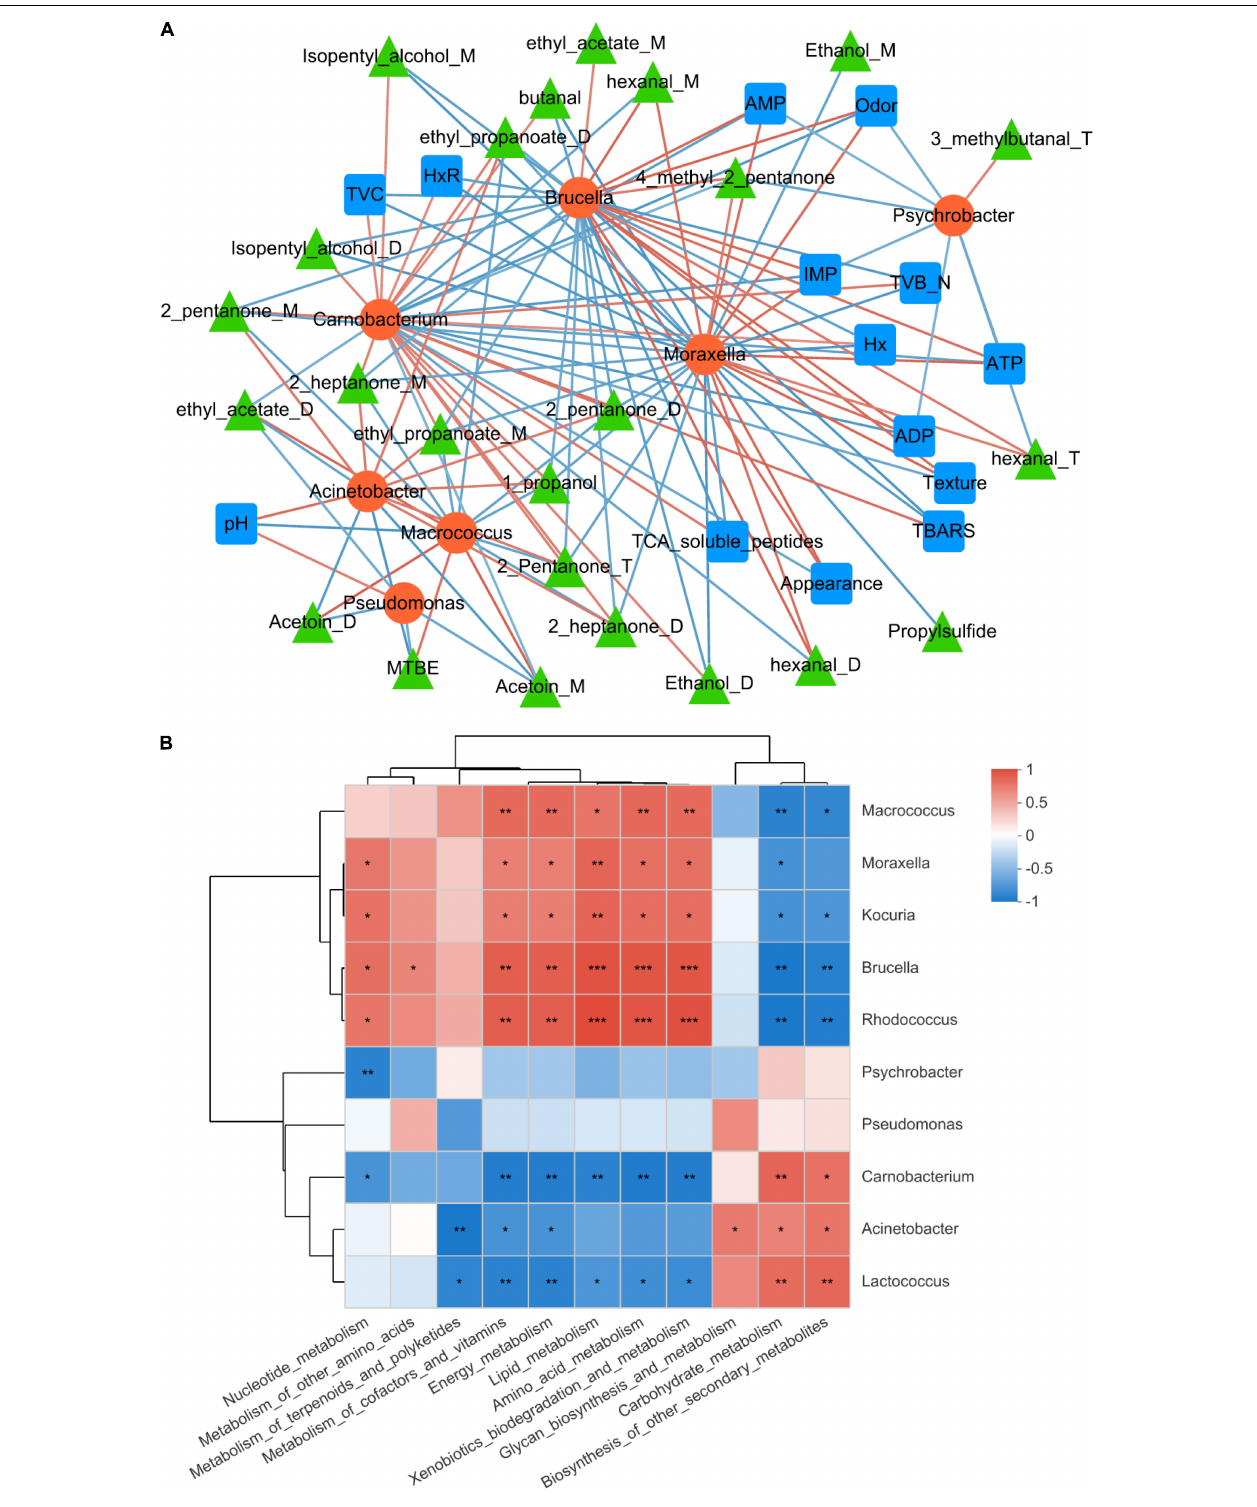
FIGURE 5 | Network analysis of the correlation among microbiota, biochemical changes, and metabolic pathways. (A) Correlation between the dominant bacteria and biochemical changes. (B) Correlation between the dominant bacteria and metabolic pathways. The microbiota was considered at the operational taxonomic unit level, and statistically significant Pearson correlations were calculated among the sturgeon samples. A connection stands for a significant ( P < 0.05) and positive (Pearson correlation > |0.7|) correlation. * p < 0.05, ** p < 0.01, *** p < 0.001.